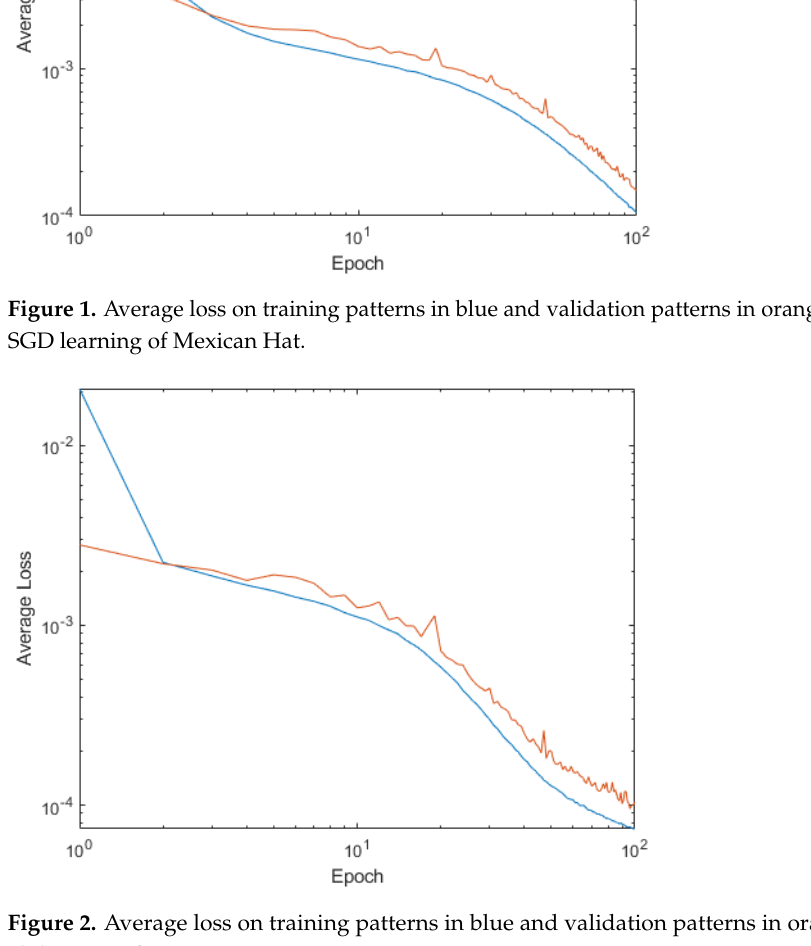
Figure 1. Average loss on training patterns in blue and validation patterns in orange for the stand- ard SGD learning of Mexican Hat.